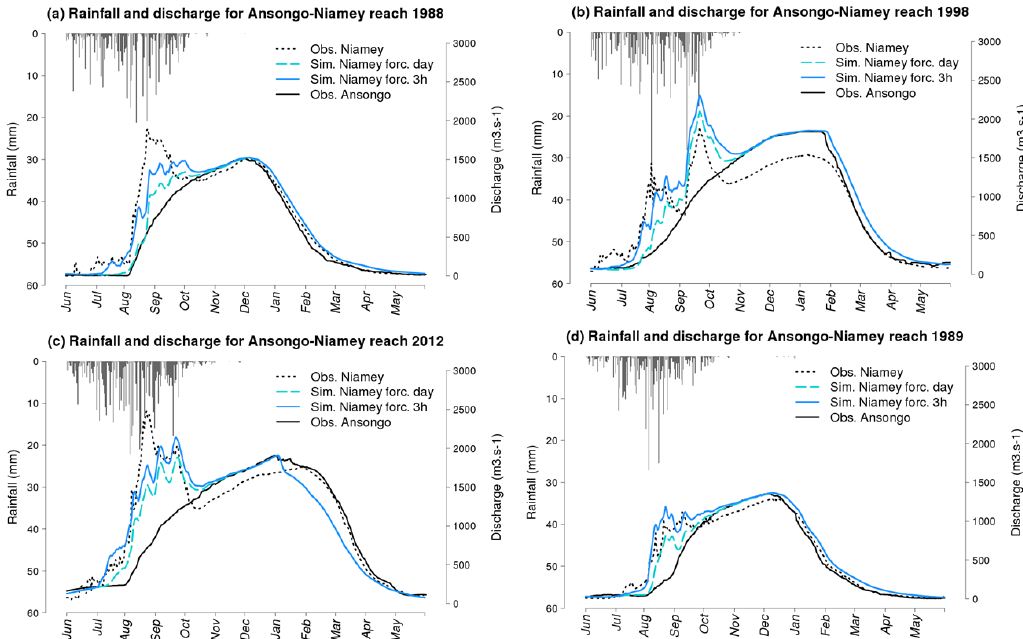
Figure 4. Mean daily rainfall on the study area (upper plot; solid grey bars), observed discharge in Ansongo (solid black line) and Niamey (dotted black line) and simulated discharge with uniform daily rainfall (dashed blue line) or 3h rainfall (solid blue line); in 1988 (a) , 1998 (b) , 2012 (c) and 1989 (d) .